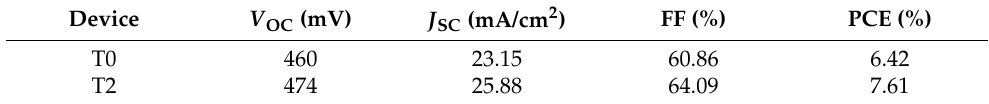
Table 3. Device characteristics of the Sb 2 Se 3 solar cells with or without Te